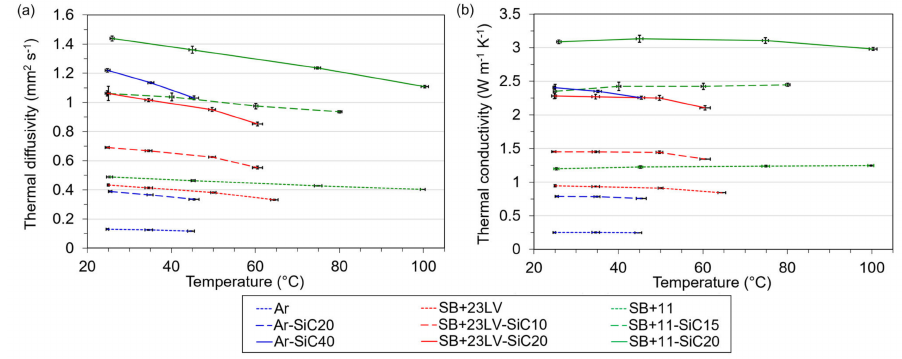
Figure 6. Temperature dependence of thermal di ff usivity ( a ) and thermal conductivity ( b ) for prepared